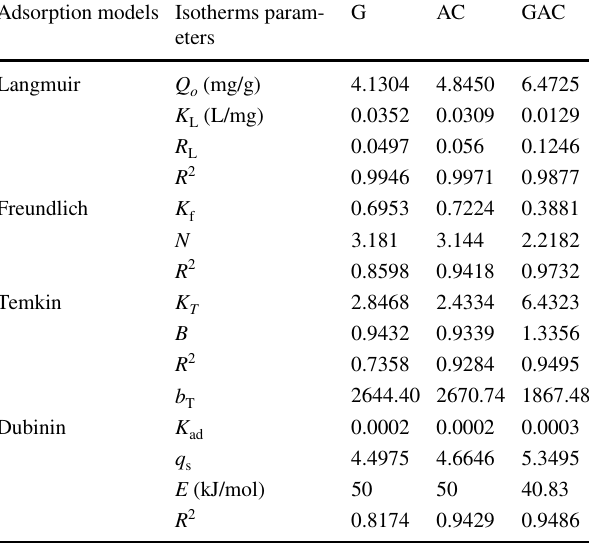
Fig. 10 Freundlich isotherm plot Cr(VI) on G, AC and